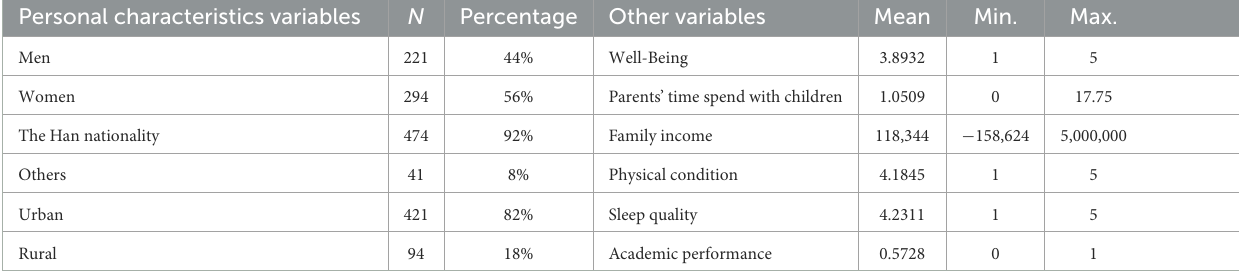
TABLE 3 Descriptive statistics of each